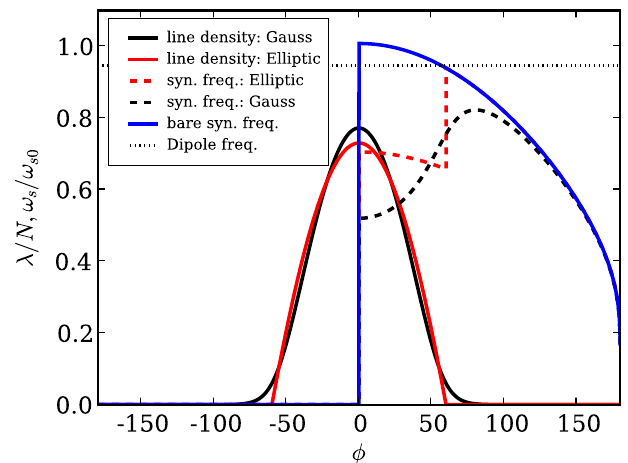
FIG. 2. (Color) Matched line densities for (cid:1) (cid:7) 1 and bunch (cid:7) 60 (cid:12) in the case of equivalent matched elliptic length (cid:1) m and Gaussian bunch distributions in a single rf wave. The dashed curves correspond to the respective synchrotron frequencies. The horizontal line represents the dipole